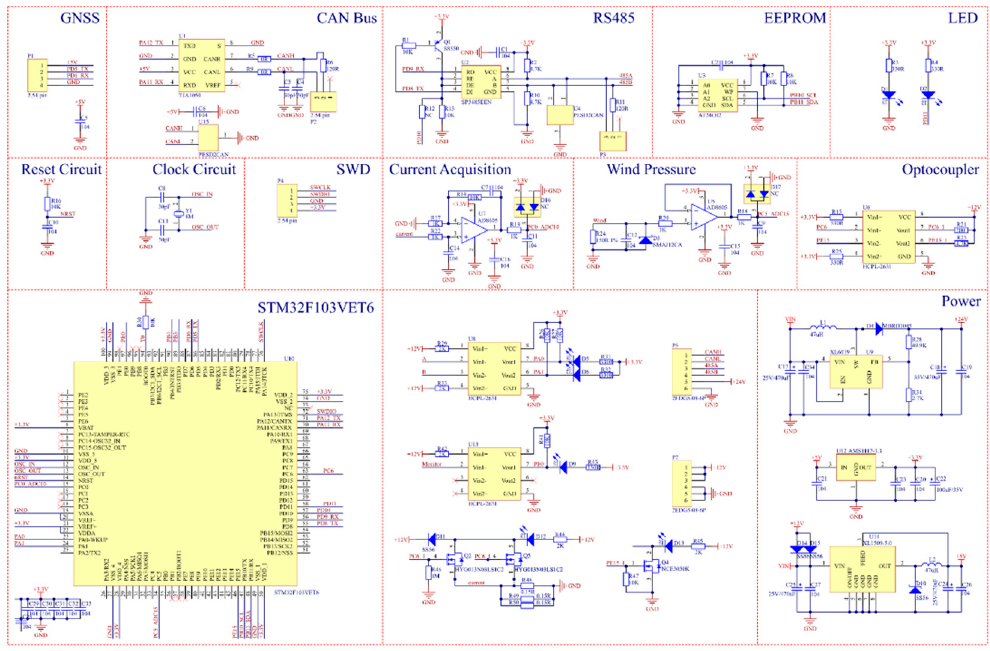
Figure 2. Schematic diagram of the system circuit.